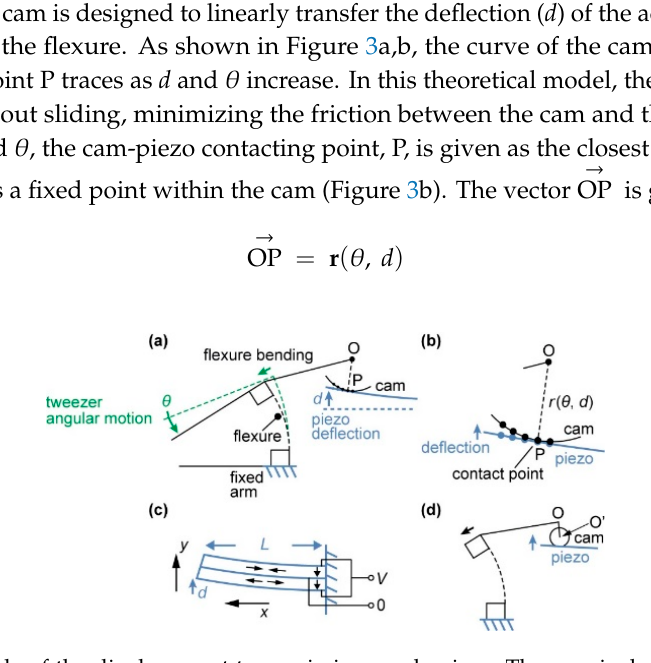
Figure 4. Photograph of the tweezer system. Figure 5. System block diagram.